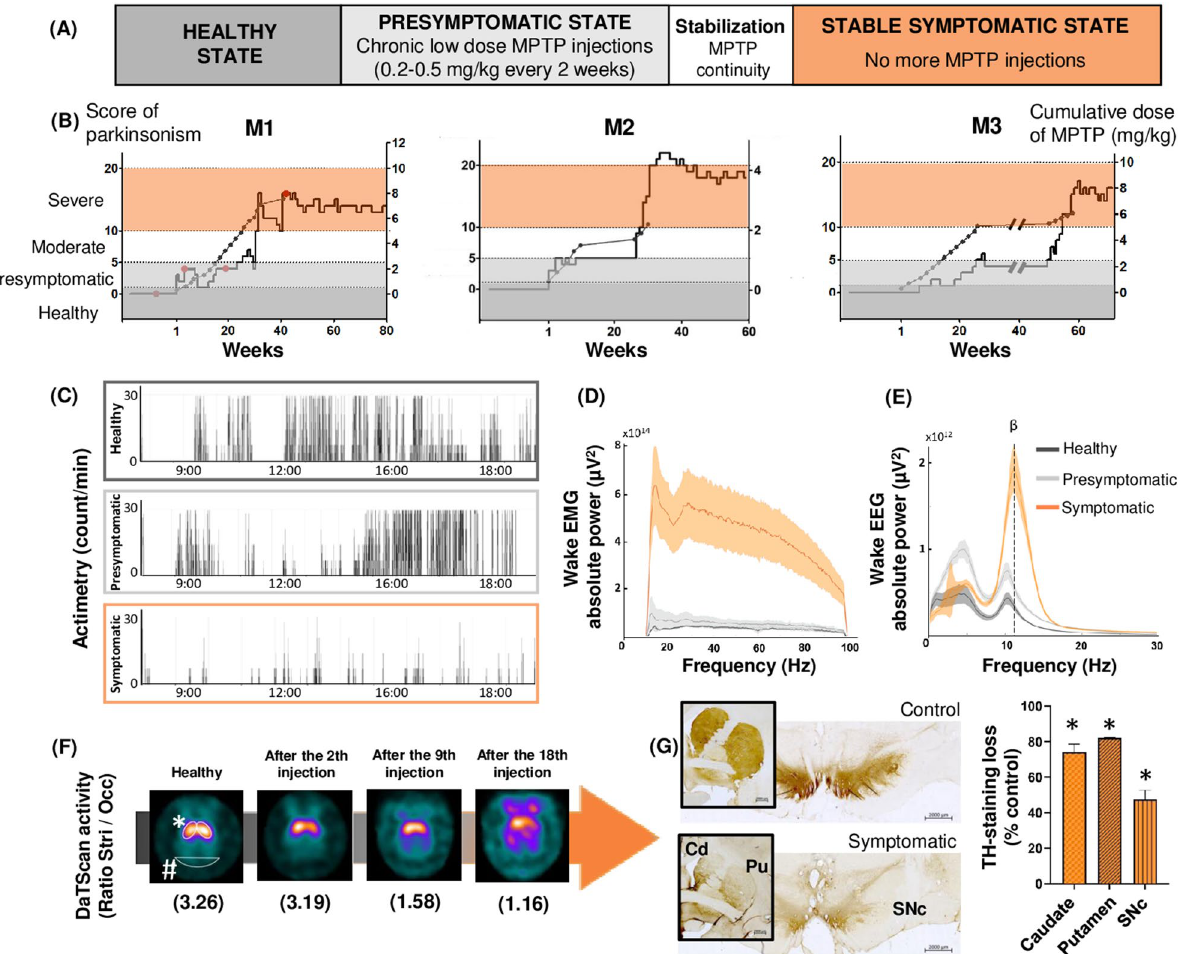
Figure 1. Panel of graphs showing the motor symptoms evaluation. ( A ) Schematic design study for the 3 keys periods: healthy (dark grey), presymptomatic (light grey) and symptomatic (orange) states with 8 weeks in mean of stabilization. ( B ) Longitudinal progression of Parkinson’s disease for M1, M2 and M3, induced by injection of chronic low doses of MPTP, based on weekly observations. Solid black line shows the score of parkinsonism, gray line with dot shows the cumulative dose of MPTP where each dot corresponds to an injection of 0.2–0.5 mg/kg. The red dots on M1 graph correspond to the DaTScan imaging. The line break on M3 graphs correspond to a 2-month break due to infection problems, not taken into account in analyses. ( C ) Actimetry expressed in count/min across different states of the disease from 7:00 to 19:00. ( D ) EMG spectral power density (µV 2 /Hz) during active wake across different states of the disease; healthy in dark grey, presymptomatic in light grey and symptomatic in orange, expressed in mean ± 95% confidence interval. ( E ) EEG spectral power density (µV 2 /Hz) during active wake across different states of the disease; with the appearance of low-beta activity during symptomatic state. ( F ) Study of the uptake of the Ioflupane tracer (I-123) in M1, by DaTScan nuclear imaging examination, according to the different states of the disease. * indicate regions of interest (striatum analysis area for activity measurement) and # indicate reference region (cerebral background noise measurement). Note the asymmetric pattern against the left side from the 2nd injection of MPTP, which persists with the disease progression, and the progressive increase in cerebral background noise which indicates a difficulty of tracer fixation by lack of dopamine transporters. The ratio striatal/occipital activity is in parentheses under each image. ( G ) Micrographs of control vs. symptomatic animal showing tyrosine hydroxylase (TH) immunostaining, at the level of the striatum (framed image, scale bar = 2000 µm) and the substantia nigra (scale bar = 2000 µm), associated with graph showing the mean percent loss of TH expression in the caudate (Cd), the putamen (Pu) and the substantia nigra compacta (SNc) compared to the control animal (Mann–Whitney U test, p <